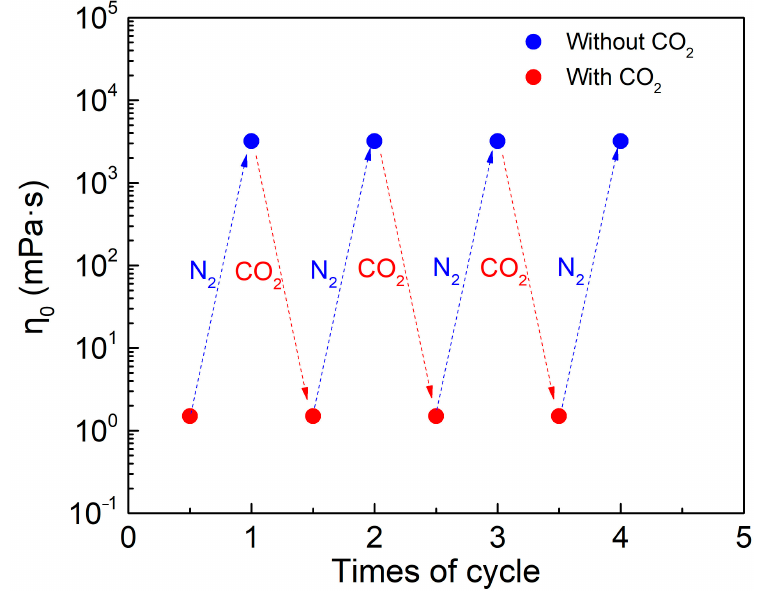
Figure 2. The reversible switchability of SA/cyclen (300 mM) in the absence or presence of CO 2 at 25 °C; the shear rate is 10 s − 1 .